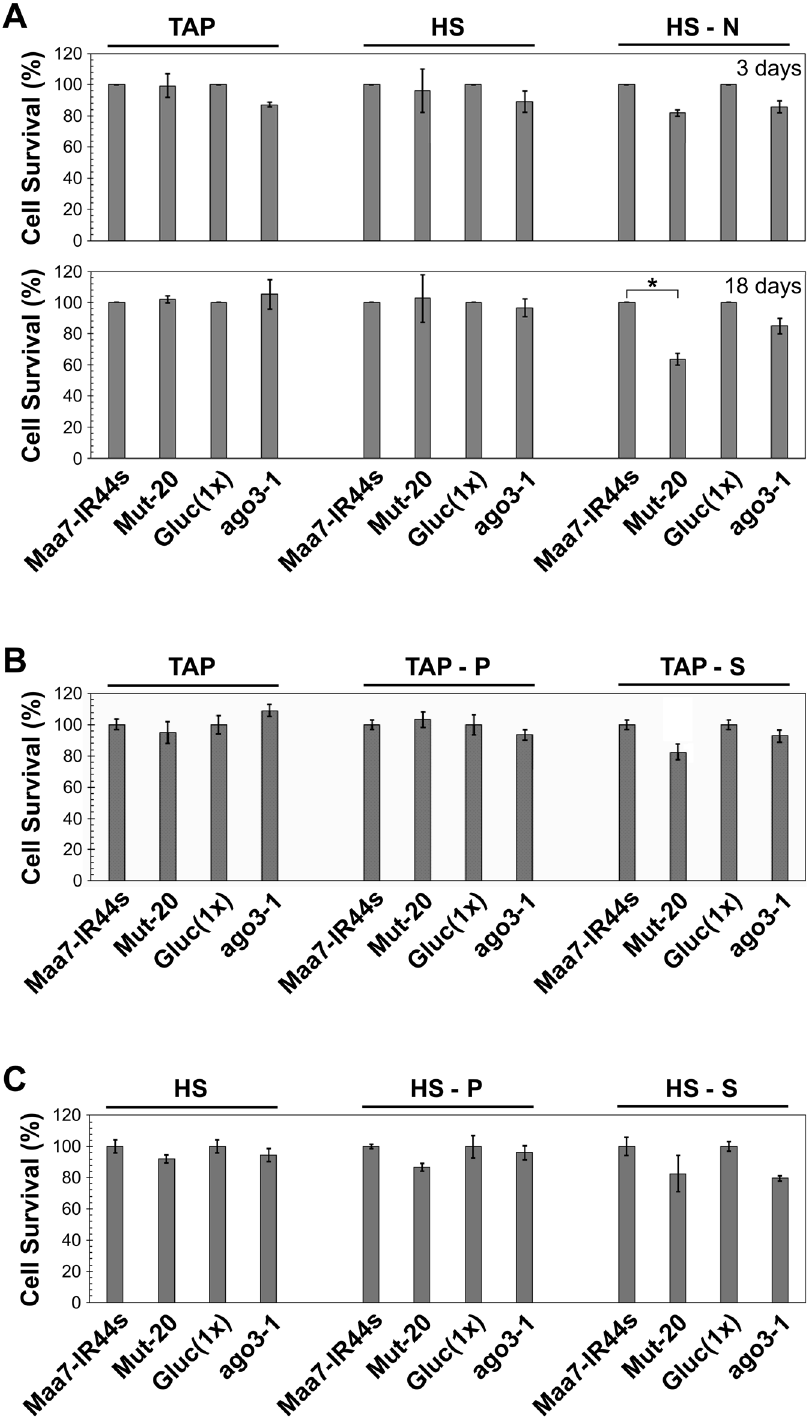
Figure 5. Viability of wild-type and RNA interference defective strains subjected to nutrient deprivation conditions. Cells were cultured in liquid medium, either replete or lacking a specific nutrient, for certain number of days and then spread on TAP-agar plates to assess survival as colony forming units. Values shown are the average of three independent experiments ± SD and are normalized to those of the control strains under each trophic condition. Maa7-IR44s, CC-124 strain containing a transgene expressing FLAG-tagged AGO3; Mut-20, TSN1 deletion mutant, in the Maa7-IR44s background, defective in sRNA biogenesis 14 ; Gluc(1x), wild type strain derived from CC-124; ago3-1, AGO3 disrupted mutant, in the Gluc(1x) background, defective in RNA interference 28 . ( A ) Cell survival of the indicated strains grown mixotrophically (TAP) or photoautotrophically in the presence (HS) or absence (HS − N) of nitrogen for 3 or 18 days. Samples